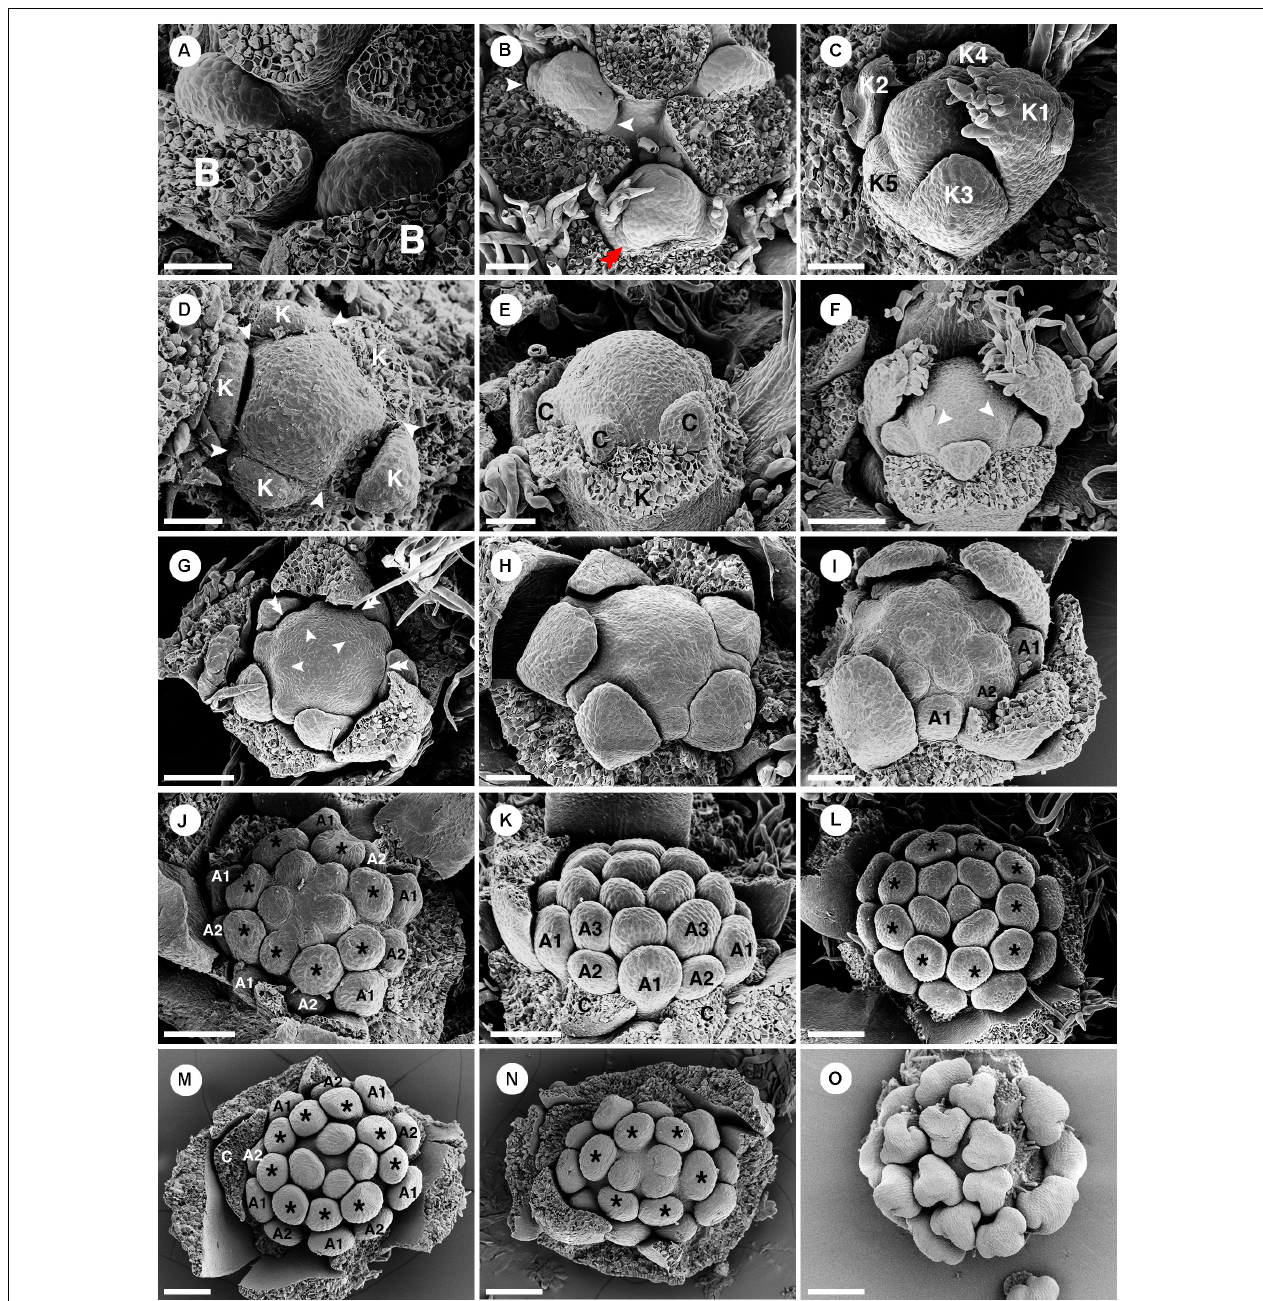
FIGURE 5 | Ontogeny of staminate flowers of Croton chilensis . (A) Young floral primordia subtended by a bract. Note, the floral apex has a convex shape. (B) Sequence of early floral development with formation of bracteoles (arrowhead) and a first sepal (double arrowhead). (C) An older bud shows unidirectional unequal growth of sepals with the initiation of petal primordia. (D) Apical view of a very young flower bud with initiation of petal primordia (arrowhead). (E) In later stages, young petals grow and expand surrounding the central floral apex. (F) While petals are growing, the first whorl of stamens develops alternating with petals (arrowhead). (G) Next, the second whorl of stamens develops centrifugally opposite petals, while the third whorl develops centripetally alternate with the first stamen whorl. (H) Later, the fourth stamen whorl initiates. Only first, third and fourth whorls are visible. The second whorl is covered by the expanding petals which have unequal growth. (I) Next, more stamens develop but do not form a complete whorl. (J) Anomalous stamen number (eight) in the third and fourth whorls (asterisk). Five stamens are present in the central part forming a complete whorl. (K) The antepetalous second stamen whorl is pushed by the petals making the first stamen whorl become the outermost whorl. (L) Nine stamens are present in the third and fourth whorls (asterisk). Five central stamens are present but are unequally arranged. (M) The outermost stamens during a young developmental stage are stamens from the first whorl. The anomalous stamen number of nine is observed in the third and fourth whorls (asterisk). (N) A flower with an anomalous lower stamen number (total 19 stamens). Boundary between third and fourth whorls could not be observed (asterisk). (O) Later, young stamens curve toward the floral apex and become inflexed. B, bract; K, sepal; C, petal; A, stamen. Scale bars: (A–E,H,I) = 50 µ m; (F,G,K,M,N) = 100 µ m; (I,J) = 90 µ m; (L) = 120 µ m; (O) = 200 µ m.